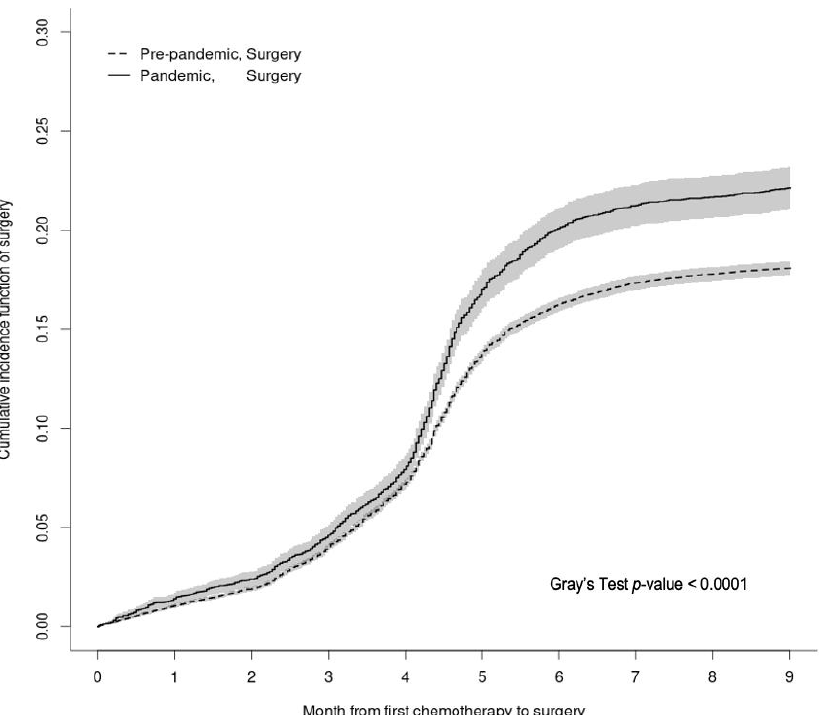
Figure 1. Cumulative Incidence functions of surgery received within 9-month after first chemotherapy for patients first treated with chemotherapy by COVID-19 period. Legend: Death (not shown) was modelled as a competing-risk event. The pre-pandemic period (dashed) is from 3 January 2016 to each time point after the date of first chemotherapy, the cumulative incidence of receiving surgery was higher in the pandemic period than in pre- pandemic (Gray’s p -value < 0.0001).